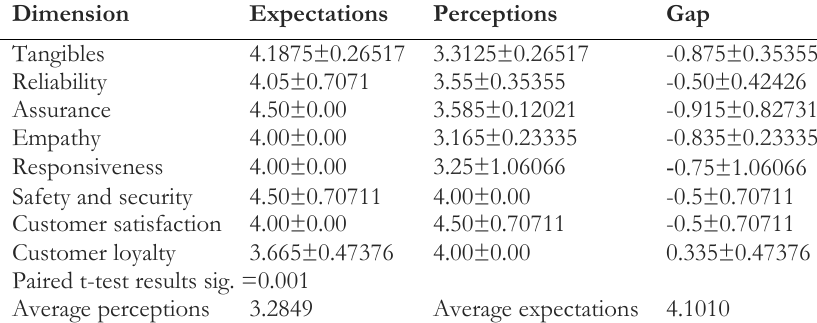
Table 6. Gap quality analysis of reverse support services - unit 3.